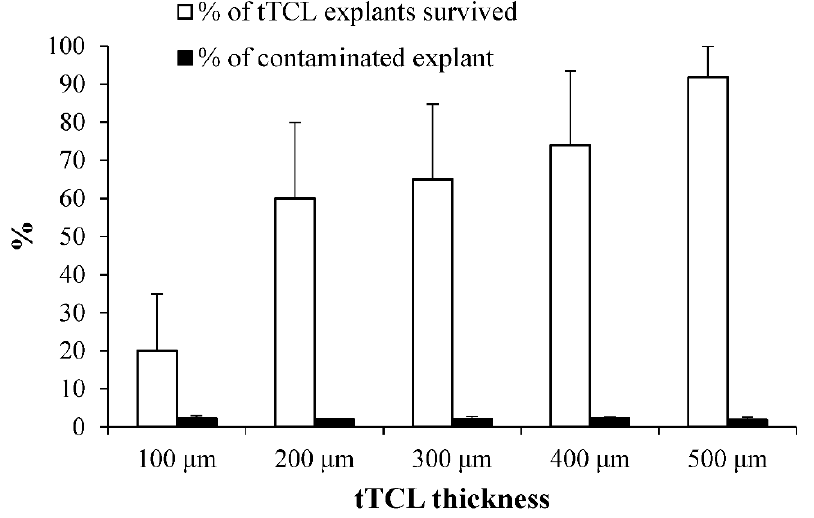
Figure 3. Effect of tTCL thickness prepared from 10% ( w / v ) agarose and dried for 4 h on survival and contamination rate of the cultures after 10 days.